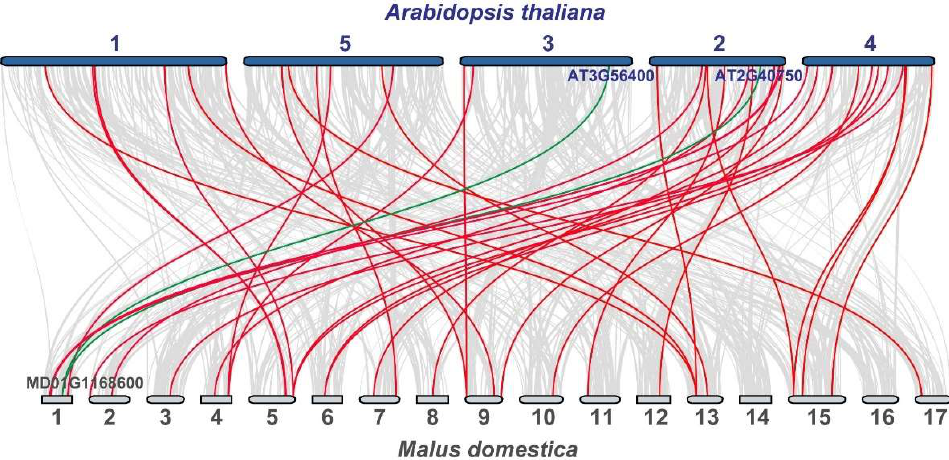
Figure 3. Synteny analysis of WRKY genes between Arabidopsis and Malus domestica . Syntenic WRKY genes of Arabidopsis ( A. thaliana ) and apple ( M. domestica ) are exhibited with red lines. Gray lines indicate the synteny blocks. The green lines indicate the synteny of MdWRKY70L ( MD01G1168600 ) and AtWRKYs ( AT3G56400 and AT2G40750 ).